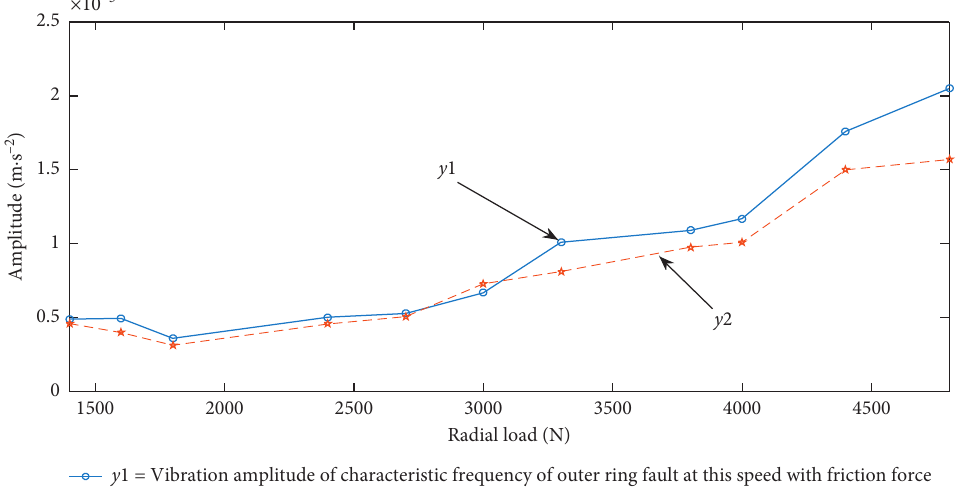
Figure 26: Amplitude trends of characteristic frequency with friction and no friction under different radial loads at 1772rpm and the defect size is 0.014